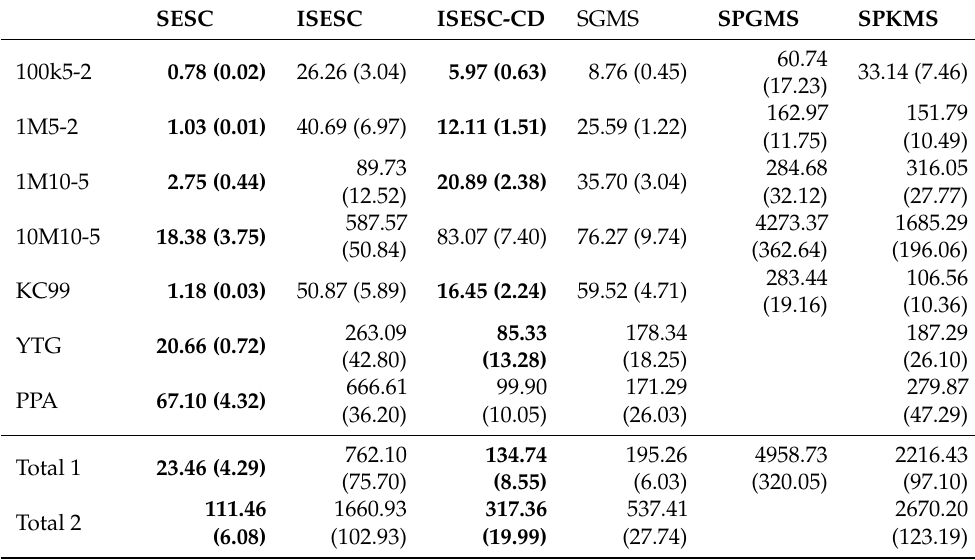
Table 5. Average execution time comparison in minutes [ µ ( σ )]. The bold cells highlight the best algorithm, or statistically equivalent, for each data